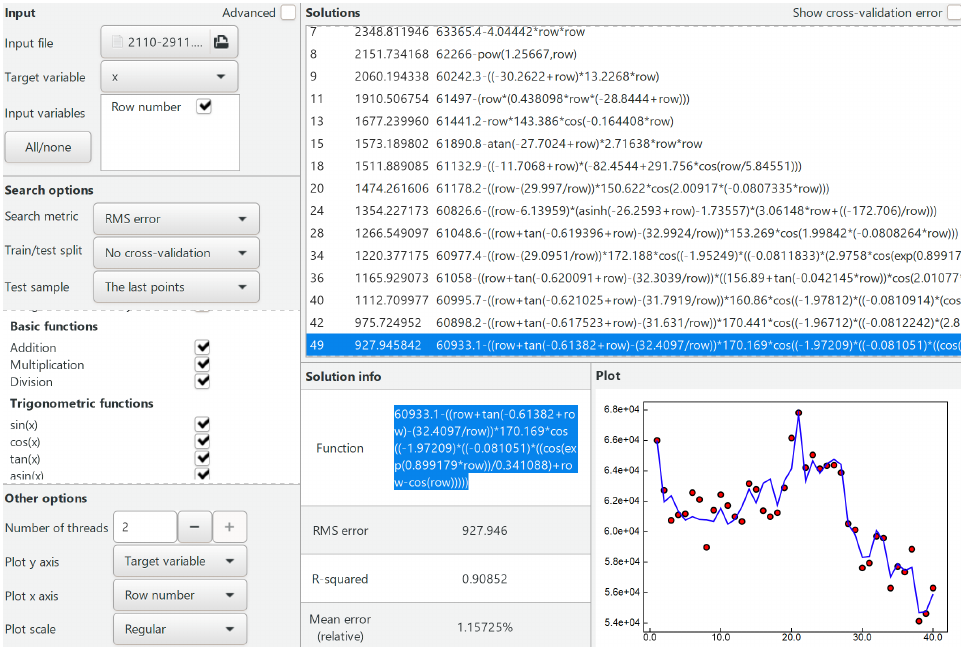
Figure 11. Example screenshot of the TuringBot Symbolic Regression Software Graphical User Interface [151] showing the evolution of formulas to simulate the 40-day BTS–USD price